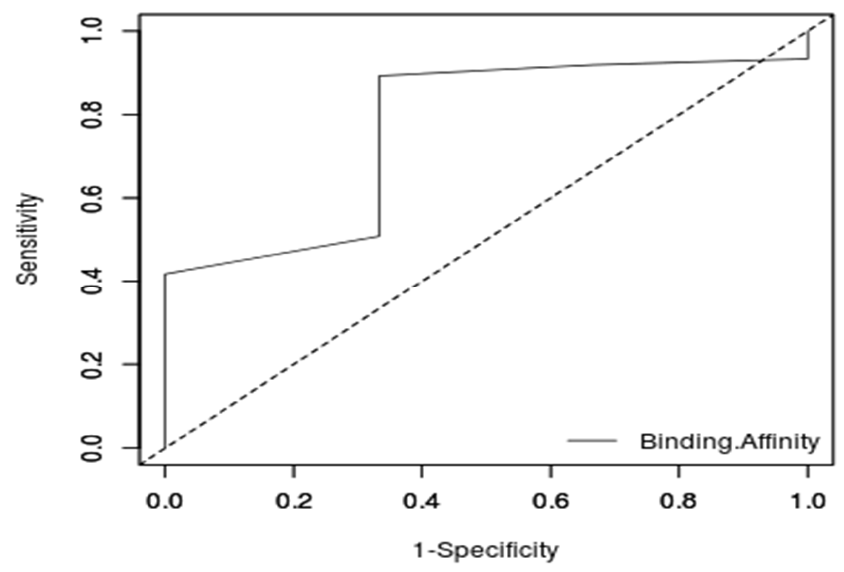
Figure 7. ROC plot generated by screening ligands active against H. pylori with their matching decoys against the protein structure, CGS of M. ulcerans . The resulting AUC was 0.76, which was acceptable.